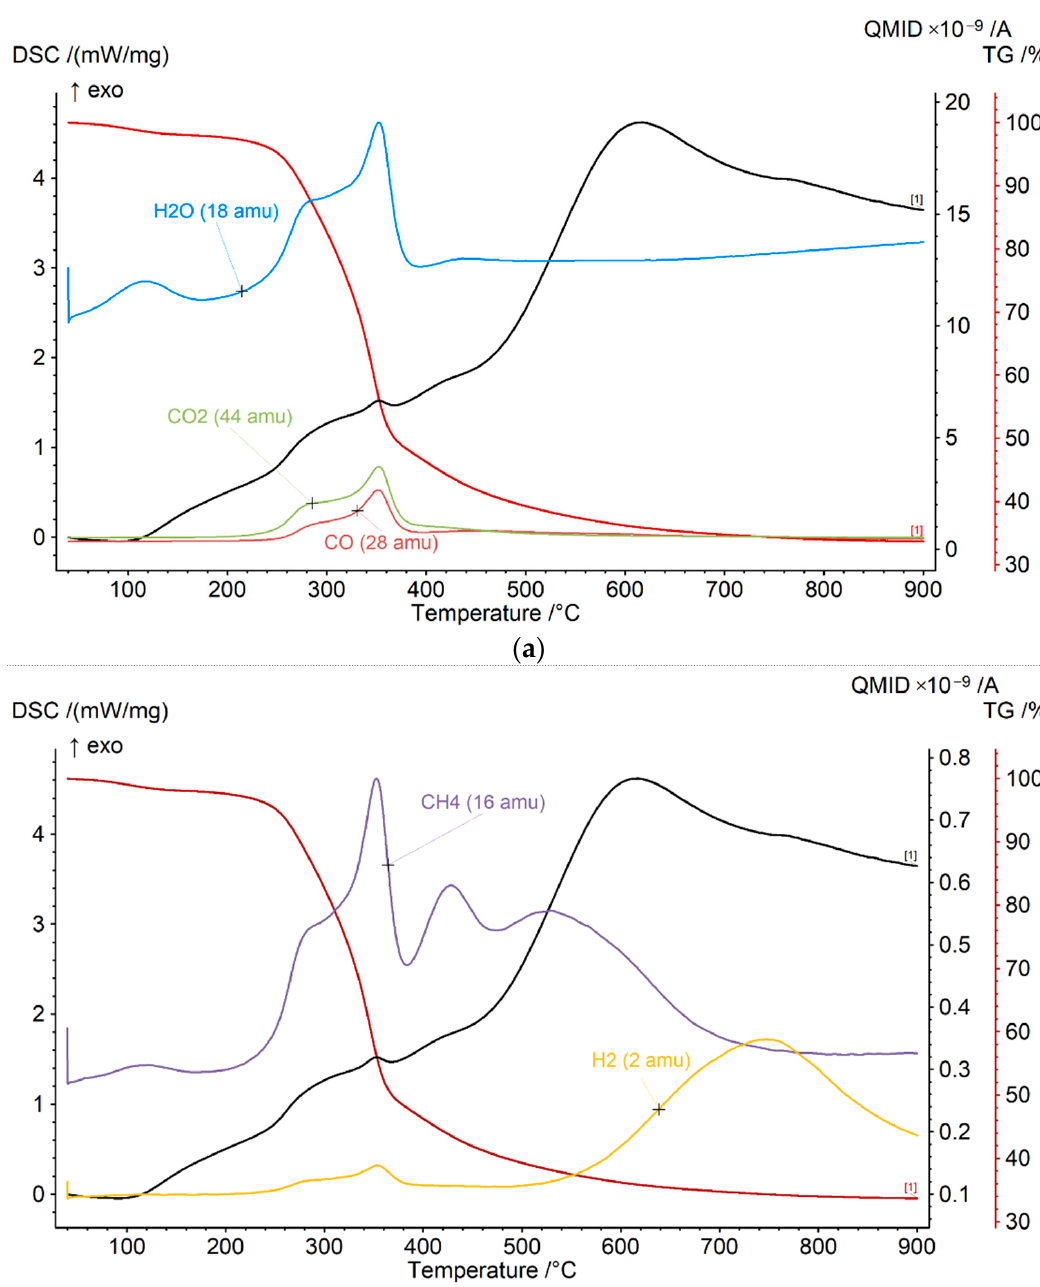
Figure 8. The pyrolysis gas composition in respect of water vapor, carbon monoxide, and carbon dioxide ( a ), and methane and hydrogen ( b ).